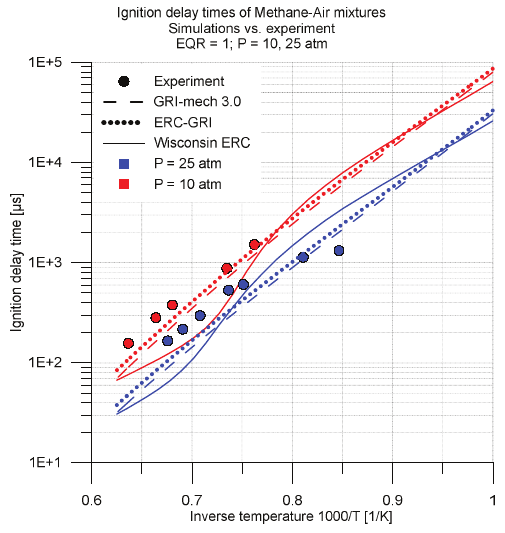
Fig. 2. Validation of IDTs for methane/air